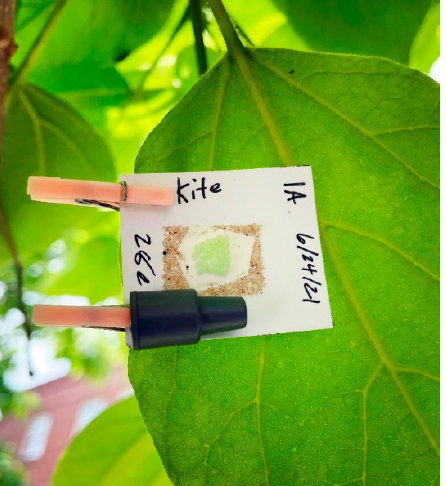
Figure 1. Deployed laboratory reared Halyomorpha halys egg mass with adjacent kairomone treatment rubber septa lure on the underside of a northern catalpa leaf in Salt Lake City, UT, from 24 June